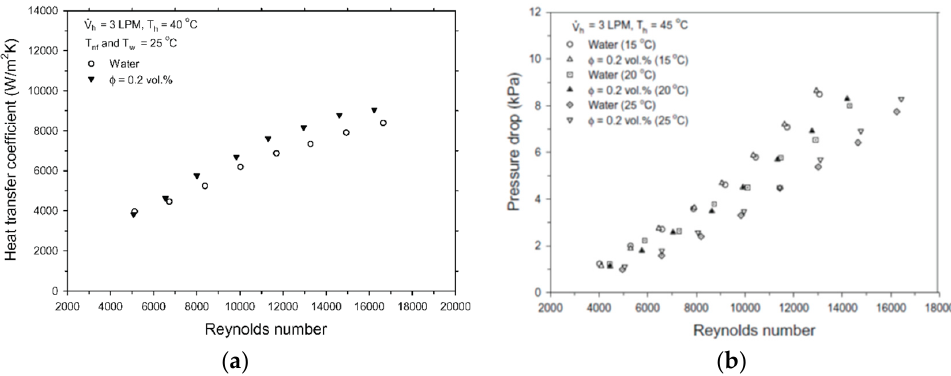
Figure 4. ( a ) Comparison of heat transfer coefficient obtained from water and that from the 0.2 vol% TiO 2 nanoparticles dispersed in water; ( b ) Comparison of 0.2 vol% nanofluid pressure drop and water pressure drop [55].